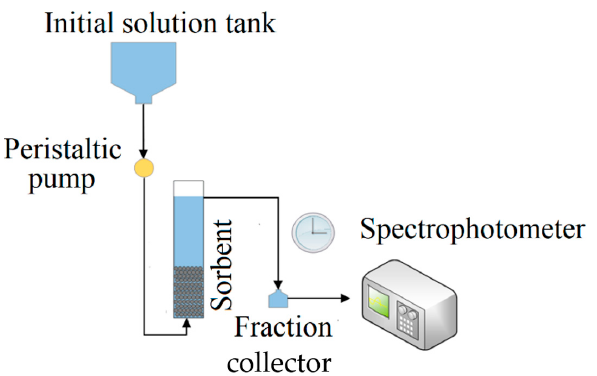
Figure 8. The scheme of the experimental setup for the sorption experiments. A peristaltic volumetric DF-12M infusion pump (Viltechmeda, Vilnius Lithuania) was applied for the column solutions with sorption materials, at four different flow rates, i.e., 2, 5, 10 and 15 mL/min. During the sorption process, the exit solutions (effluent) were analyzed periodically. The NH 4+ concentration was determined following the Nessler method [40]. The total amount of P in the solutions was evaluated according to the vanadomolybdophosphoric acid method. An HI83399 multiparameter photometer (Hanna Instruments, Nus fal ă u, Romania) was used for the evaluation of NH 4+ and total P in the solutions. The experiment for the amount of NH 4+ or phosphorous was repeated at least three times. The mean value of the triple analysis was used to calculate the amount of NH 4+ or phosphorous in solution, and the limit of error for the samples was lower than